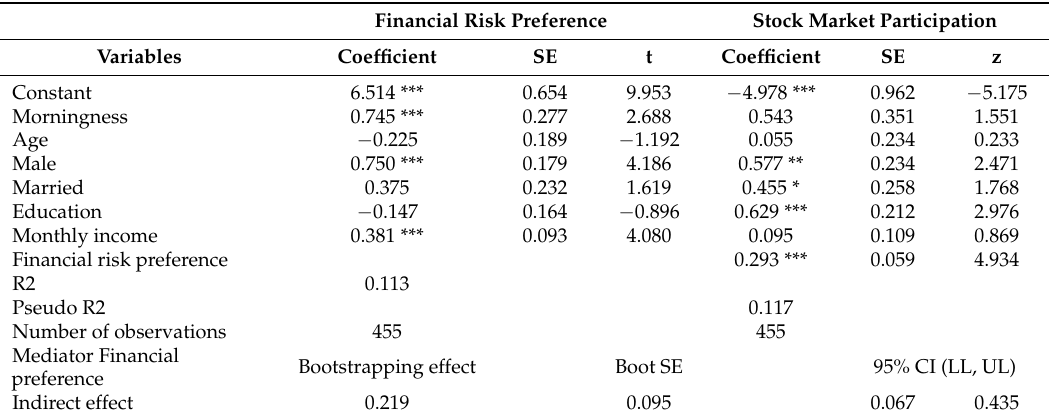
Table 8. The mediating effect of financial risk preference on the relationship between morningness and stock market participation.